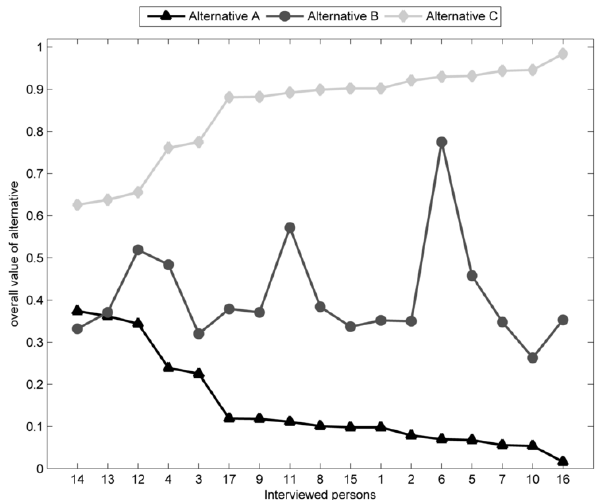
Fig. 6. Overall values of the alternatives for each interviewed Figure 6. Overall values of the alternatives for each interviewed stakeholder.